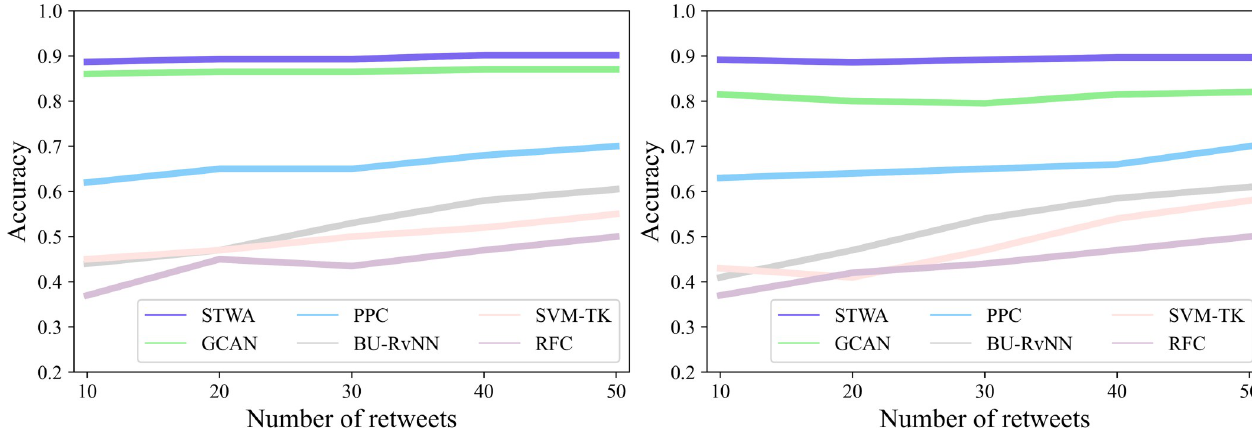
Fig 5. Results of rumor early detection (Number of retweets). (a) Early 50 retweets (Twitter15). (b) Early 50 retweets (Twitter16).